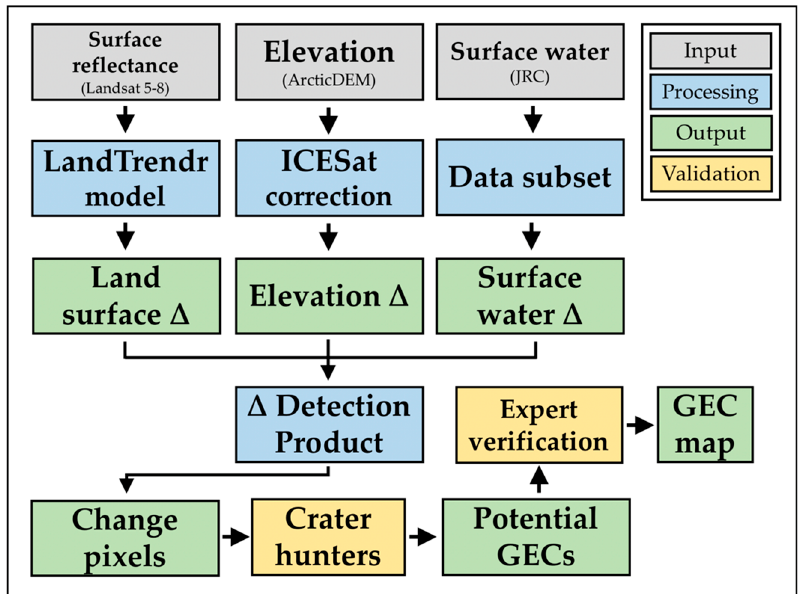
Figure 1. Summary of workflow for the change ( ∆ ) detection algorithm (CDA) and production of the GEC map.